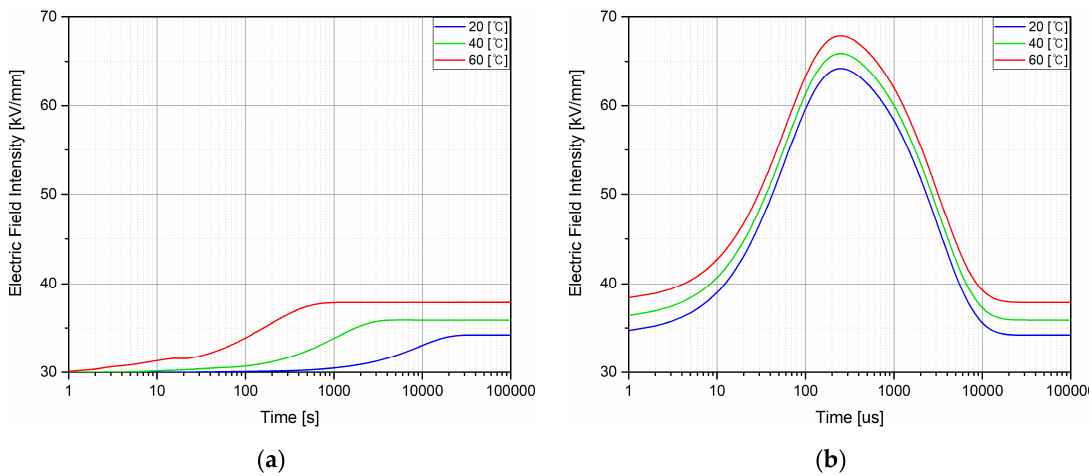
Figure 12. Comparison of current density according to superposition of switching impulse at different temperature conditions: (a) under DC voltage only; (b) under switching impulse superimposed on prestressed DC voltage.